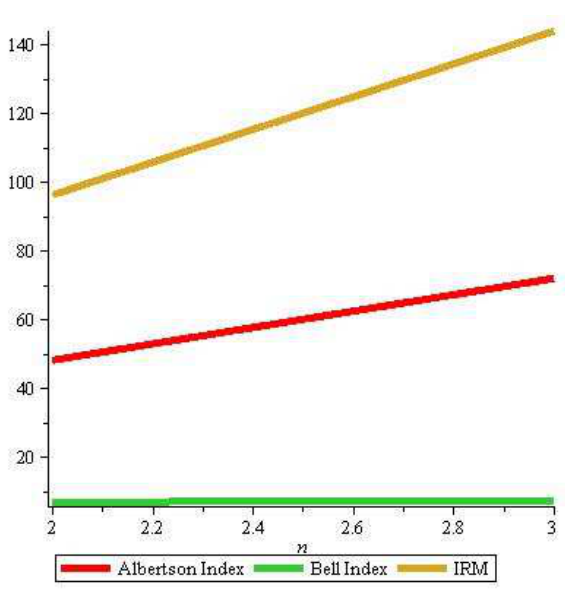
Figure 3: Graphs of Albertson, Bell, and IRM